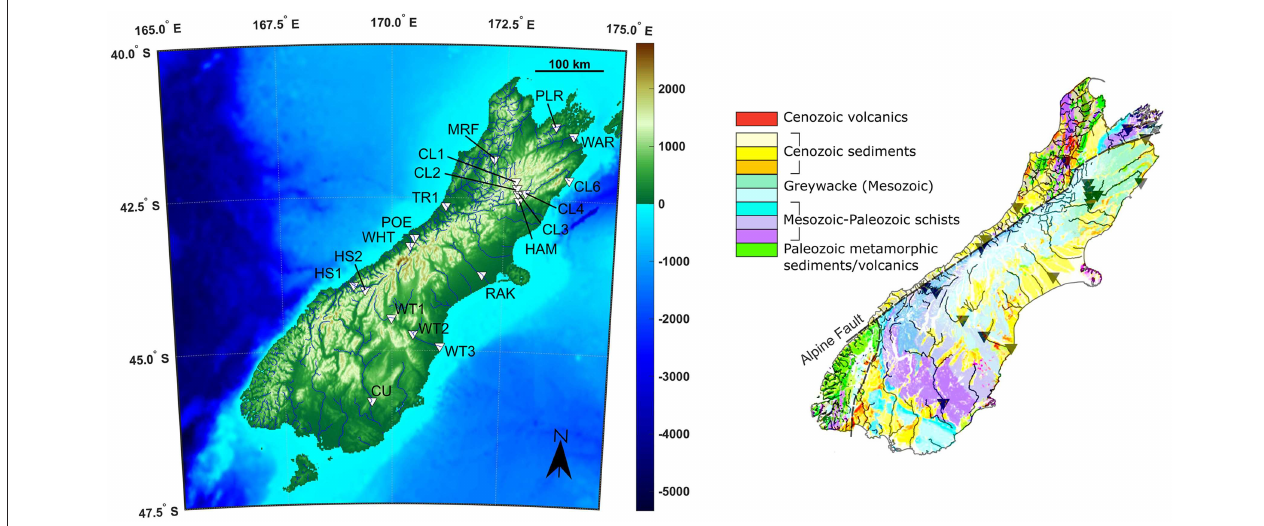
FIGURE 1 | Sample location topographical map and geological map (Geological Map of New Zealand, 2012). The Cenozoic sediments are a mixture of volcanoclastics, conglomerates, sandstones, and siltstones. Both datasets are licensed under a Creative Commons Attribution 4.0 International Public License.